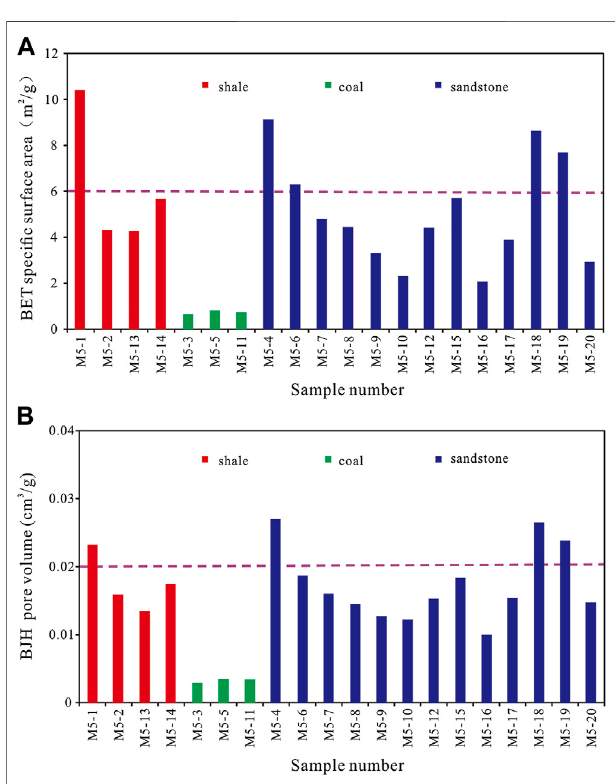
FIGURE 9 | Comparison of BET speci fi c surface area and BJH pore volume of different kinds of samples. (A) BET speci fi c surface area; (B) BJH pore